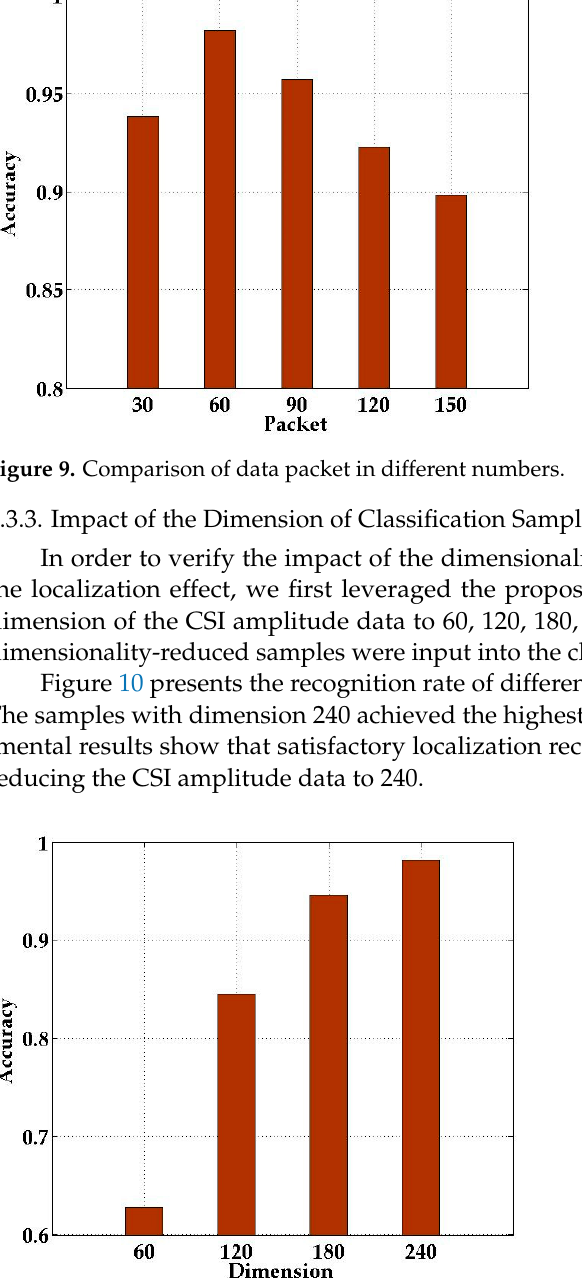
Figure 8. Comparison of nearest neighbor in different numbers.